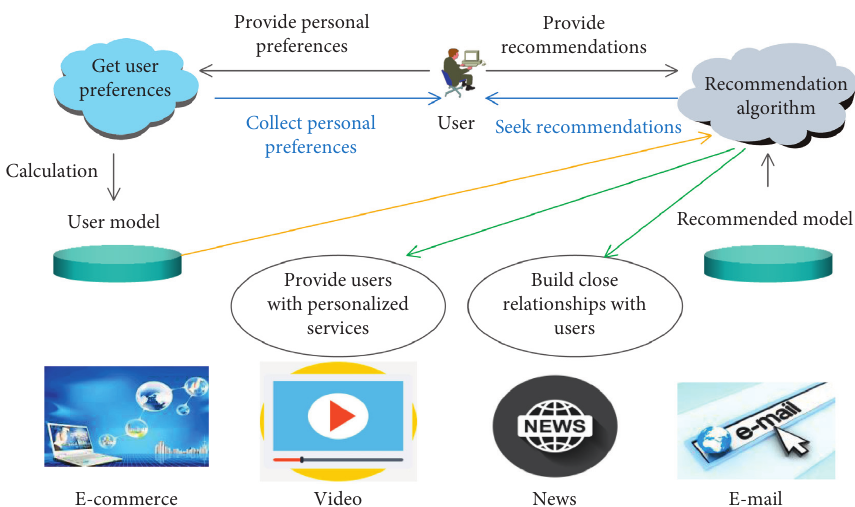
Figure 1: General model of the recommendation